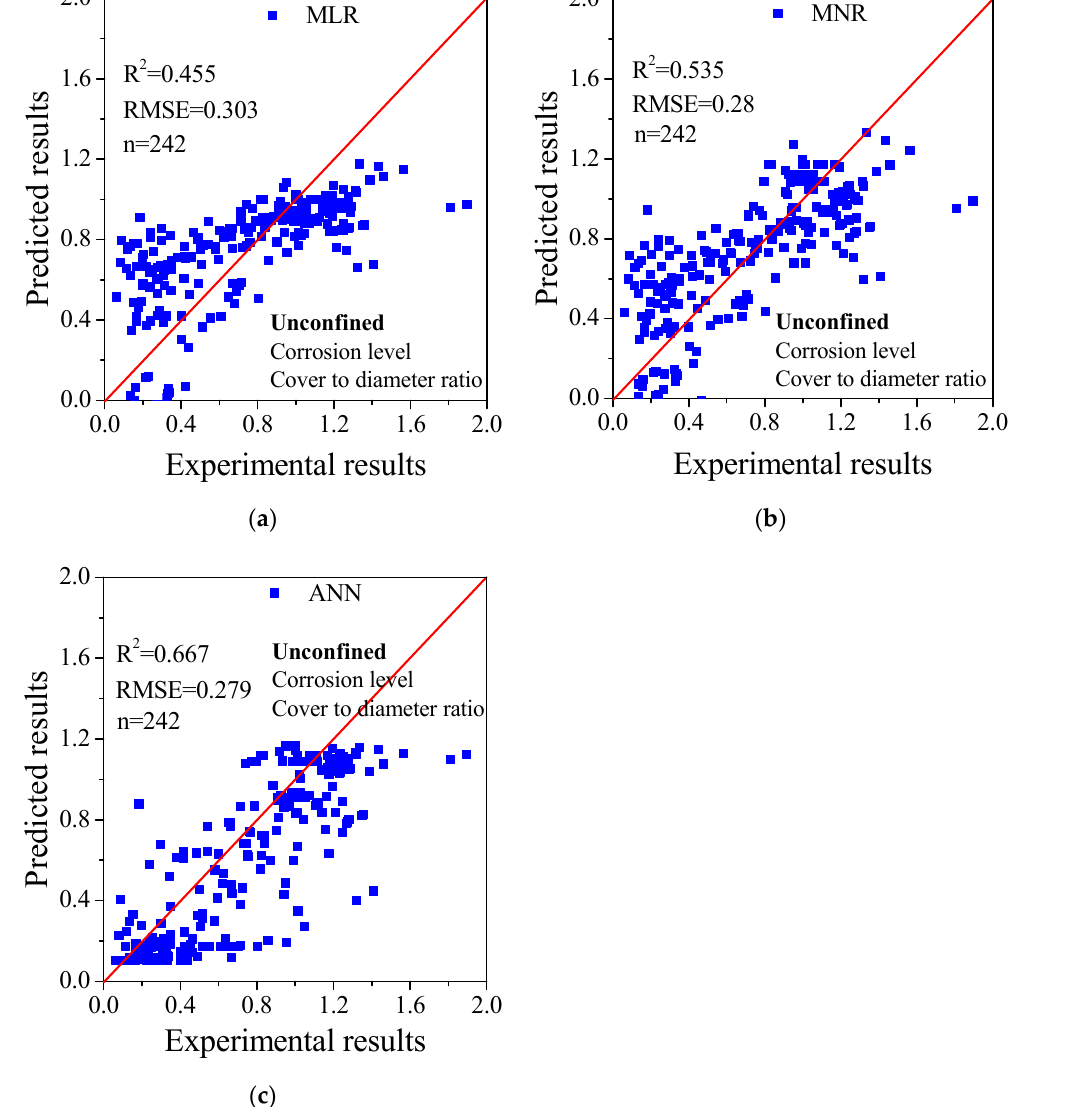
Figure 3. Comparison of the predicted results using: ( a ) multiple linear regression (MLR); ( b ) multiple non-linear regression (MNR); and ( c ) artificial neutral network (ANN).